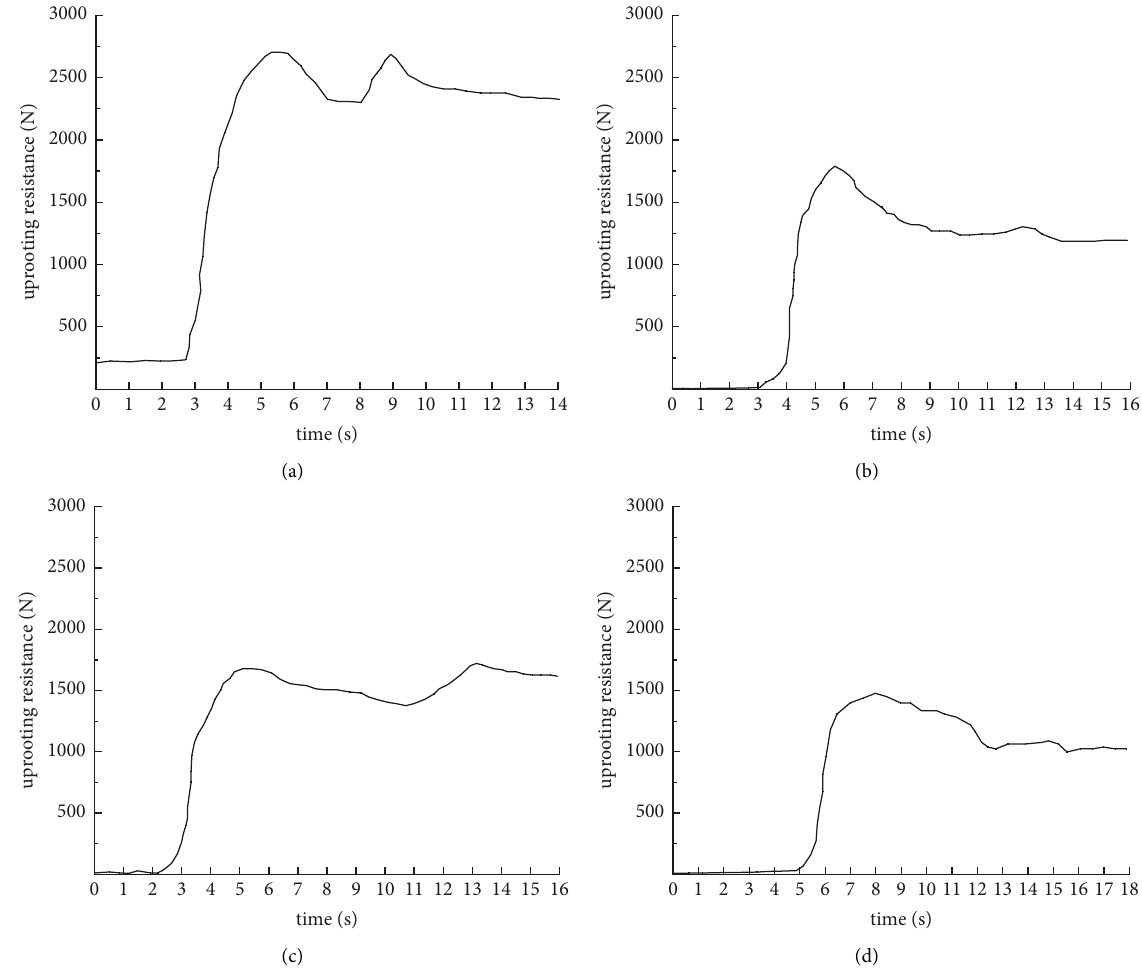
Figure 8: Test results for clay matrix, double-layer stone. (a) Test 2-1. (b) Test 2-2. (c) Test 2-3. (d) Test 2-4.